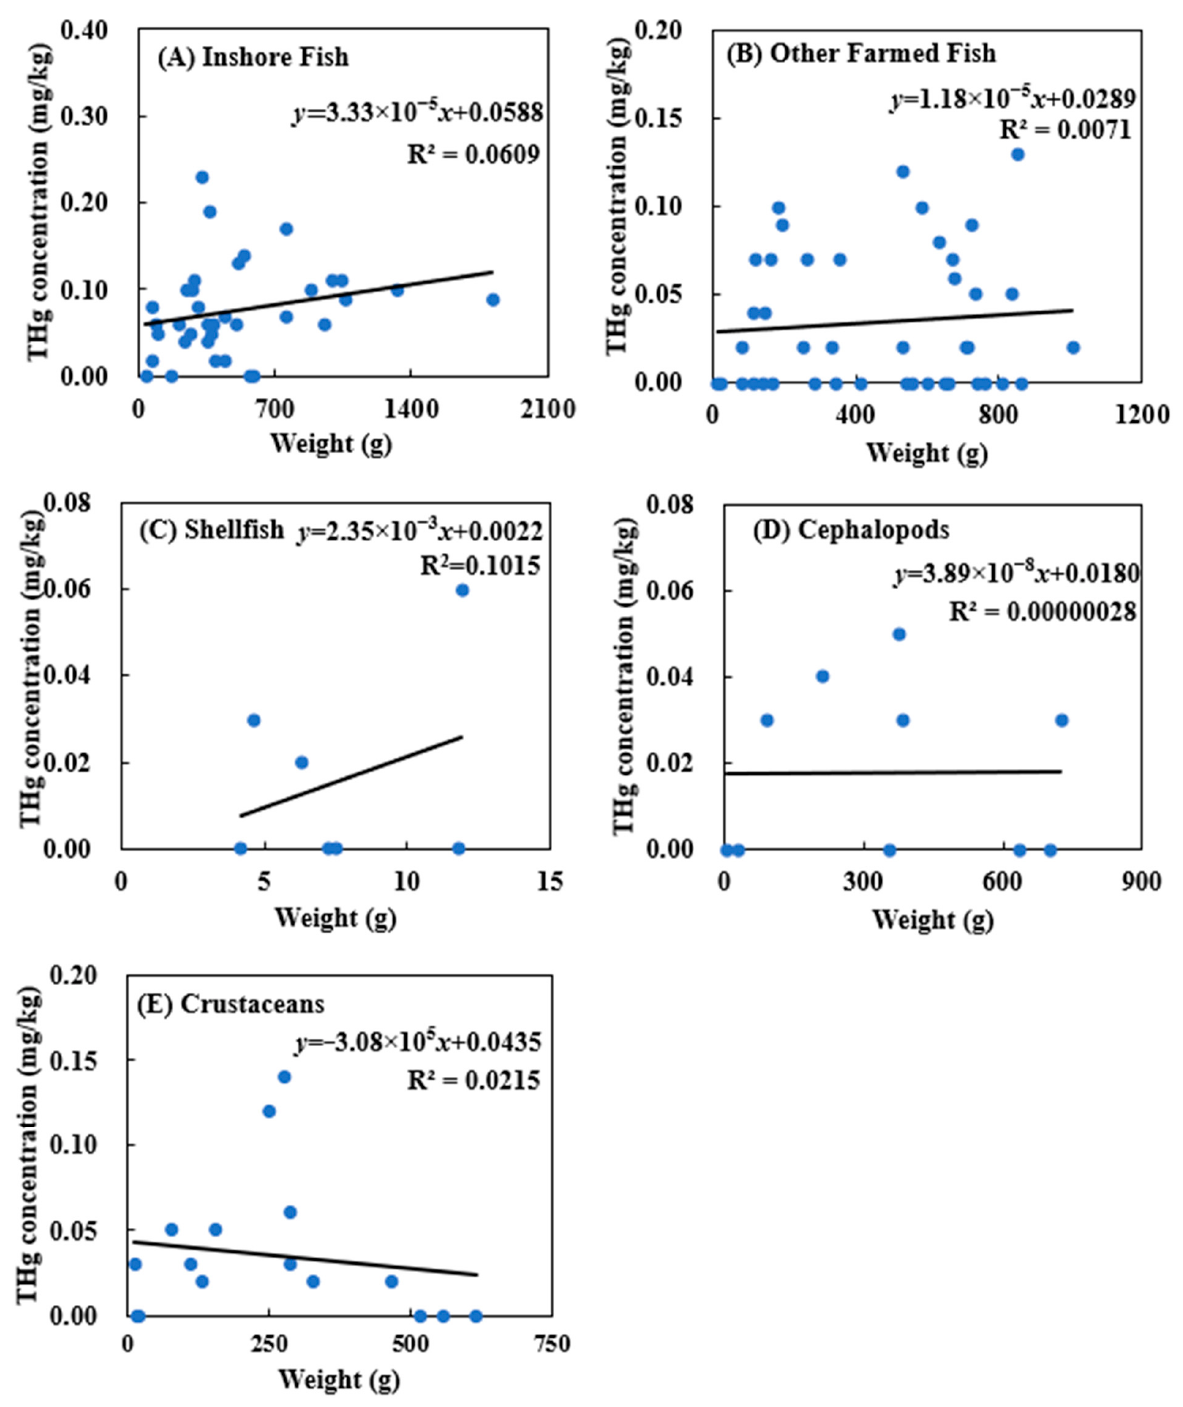
Figure 4. Correlation between total mercury concentration and weight of ( A ) inshore fish, ( B ) other farmed fish, ( C ) shellfish, ( D ) cephalopods, and ( E ) crustaceans.